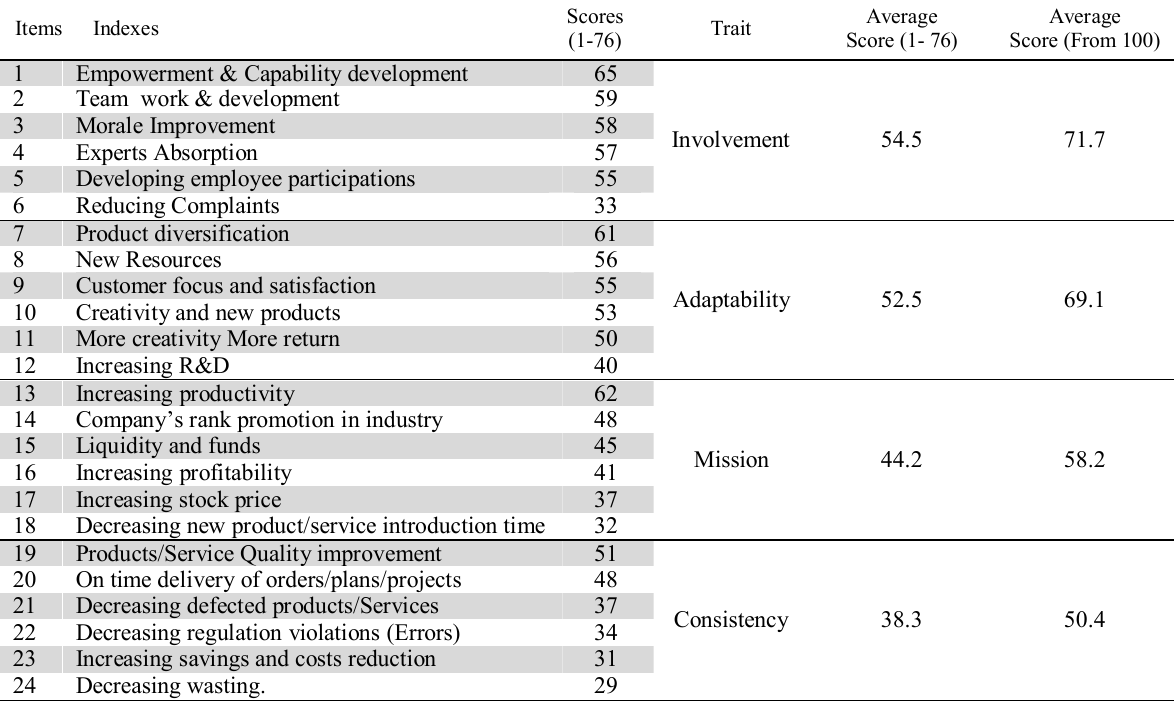
Average Score of Success Indexes of 4 Culture